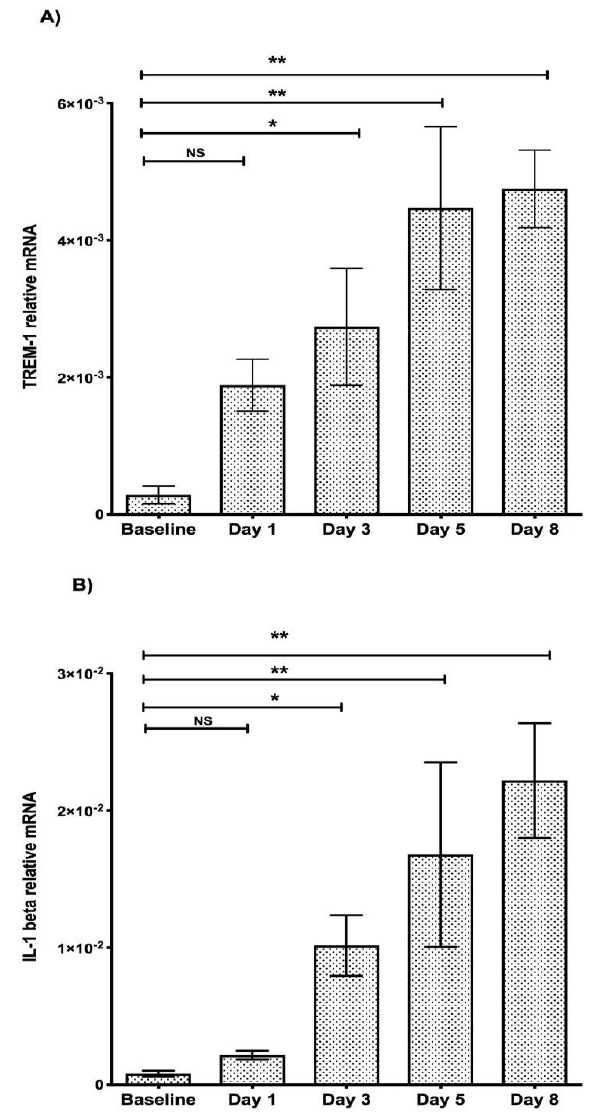
Figure 1. Kinetics of gingival tissue expression of TREM-1 and IL-1 beta in ligature-induced periodontitis. TREM-1 mRNA (A) and IL-1 beta mRNA (B) levels were examined in unligated control gingiva and ligature-induced periodontitis gingival tissues at 1 to 8 days. The gene expression levels were detected by TaqMan real-time qPCR and calibrated against the expression of housekeeping gene β-actin . Results are means ± SEM ( n = 4 mice/group). * p < 0.05 and ** p < 0.01 between the indicated groups.